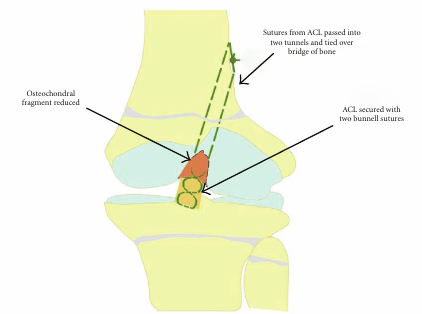
Figure 4: Schematic diagram depicting the method of repair.